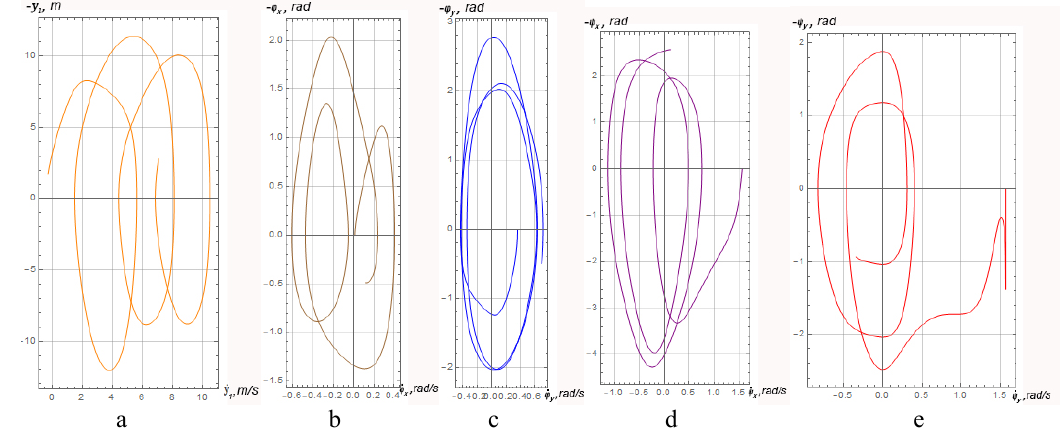
Figure 18. Phase trajectories: а –